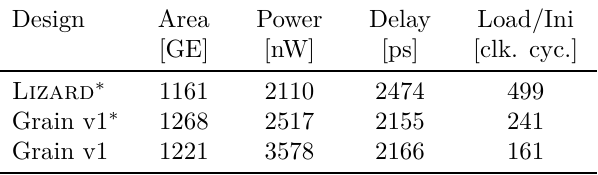
Table 1: Hardware results for a clock speed of 100 kHz. The symbol ∗ indicates that the respective implementation uses serialized key/IV loading. Latency is given as the number of clock cycles needed to perform the state initialization (including module reset and key/IV loading), denoted Load/Ini in the table. After state initialization, all designs produce one keystream bit per clock cycle, corresponding to a throughput of 100